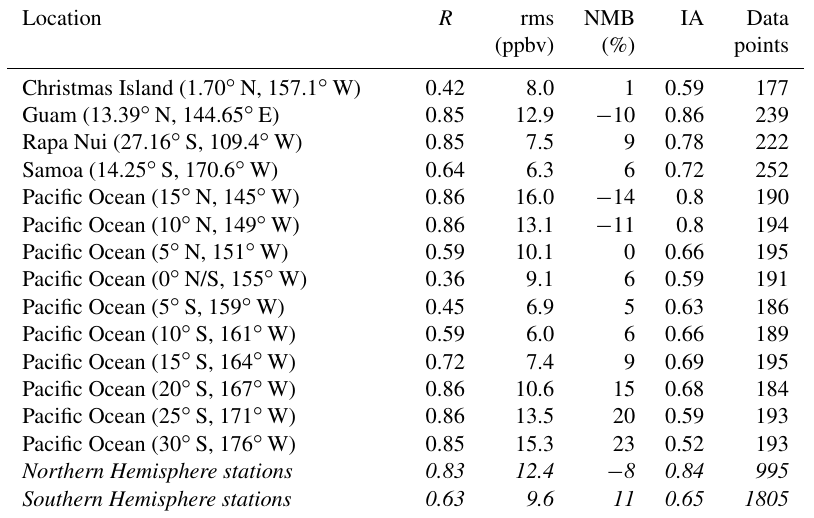
Table 4. Error statistics for model simulation versus observations of CO for 14 stations in the remote Pacific. Per definition, these indexes are calculated for data points where both observations and simulations are available over the period 1994–2014. Symbols are as in Table 2. Location